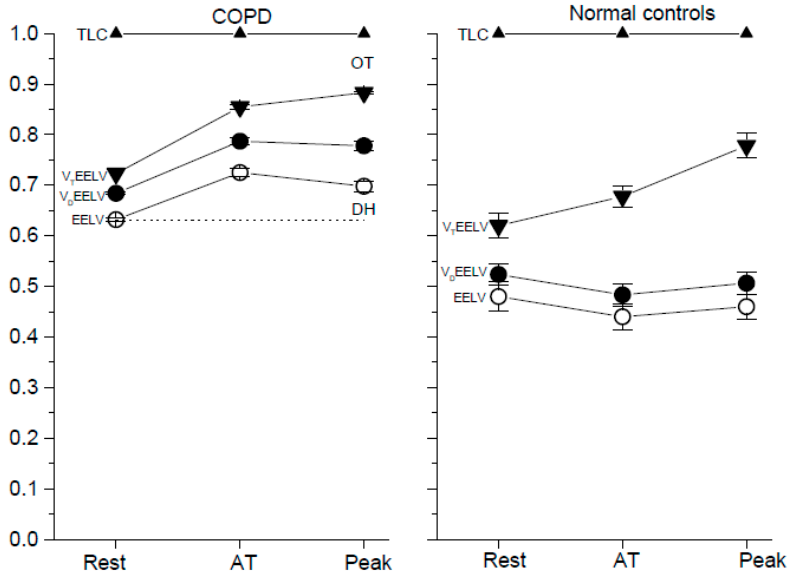
Figure 2. The % of total lung capacity (TLC, upward triangles) at rest, anaerobic threshold (AT) and peak exercise. Left panel COPD group and right panel normal controls. Open circles, end-expiratory lung volume (EELV); solid circles, dead space volume (V D ) plus EELV; down triangles, tidal volume (V T ) plus EELV (i.e., end-inspiratory lung volume, EILV); vertical bars, standard error of estimate; OT, O’Donnell threshold; DH, dynamic hyperinflation indicating EELV at AT or peak exercise minus EELV at rest; dashed line, EELV at rest. Comparisons of each compartment between COPD patients and normal controls at rest, AT and peak exercise, respectively, all p < 0.0001 except V T EELV at rest, p < 0.01 and V T EELV at peak exercise, p < 0.001. In COPD patients, comparisons of each compartments of TLC between two time points, all p < 0.0001 except EELV at AT versus EELV at peak exercise, p < 0.001 and V D EELV at AT versus V D EELV at peak exercise, p = 0.046, which was insignificant. After combining V D with DH (V D DH%), V D DH rest % was 5% ± 1% and V D DH peak % was 15% ± 5% in